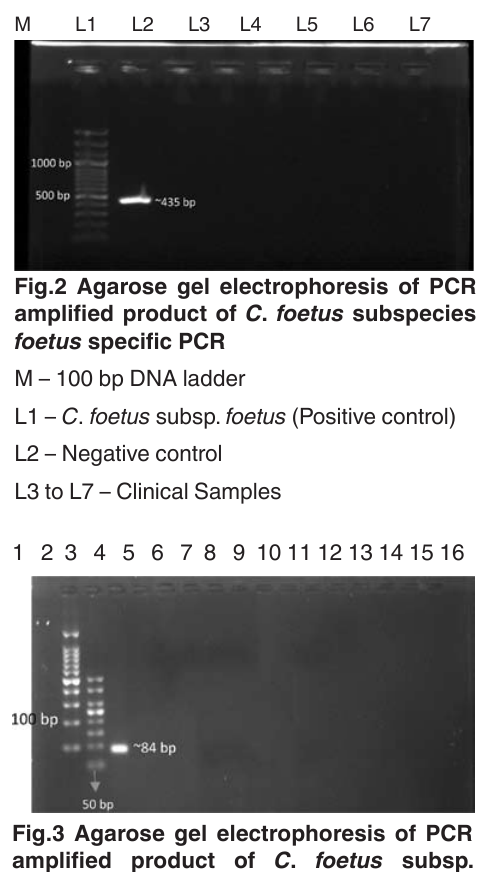
Fig.3 agarose gel electrophoresis of PcR amplified product of C . foetus subsp.